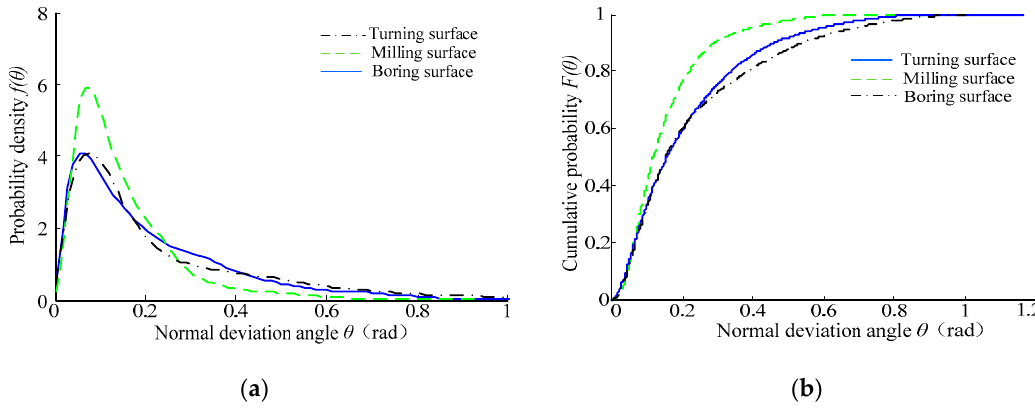
Figure 7. The distribution curves of the normal declination angle of the Ra 3.2 μ m machined surface topography. ( a ) Probability density curve; ( b ) cumulative distribution curve.